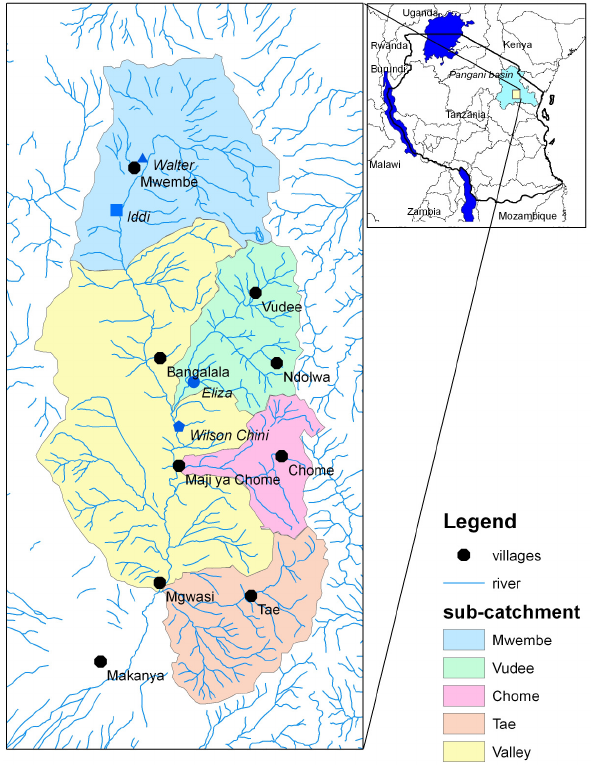
Figure 1: Location of the study areas in the Mwembe sub-catchment of the Makanya catchment in Fig. 1. Location of the study areas in the Mwembe sub-catchment northern Tanzania. of the Makanya catchment in northern